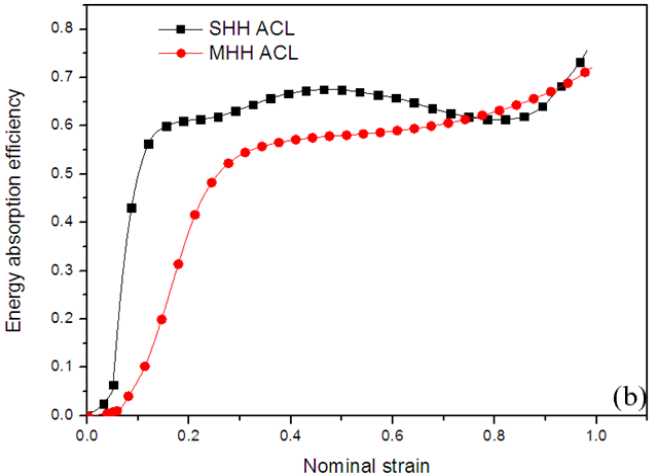
Figure 12. Energy absorption properties of resin honeycomb material under quasi-static loading: